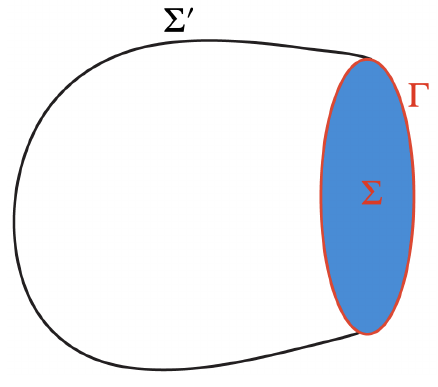
Figure 1 . Possible choices Σ and Σ 0 for fixed Γ